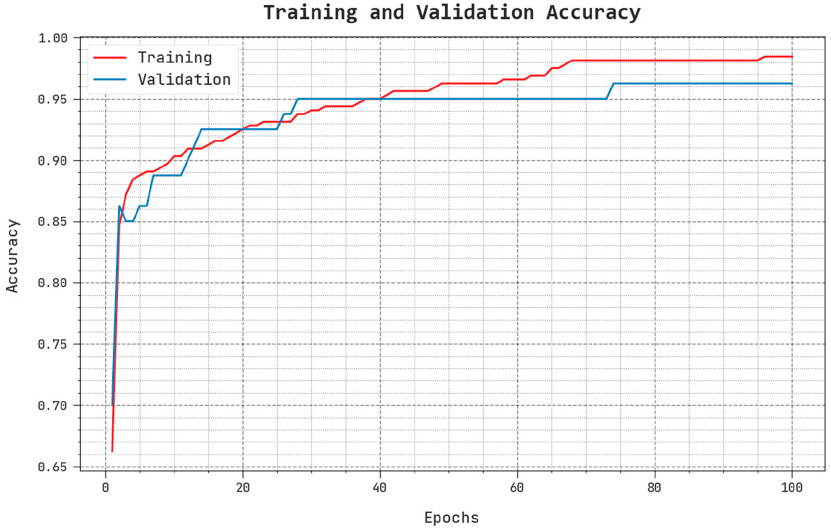
Figure 10. TLS and VLS outcomes of the BSBE-PPODLC approach. A clear precision–recall study was conducted upon the proposed BSBE-PPODLC method under the test database and the results are shown in Figure 11. The figure shows